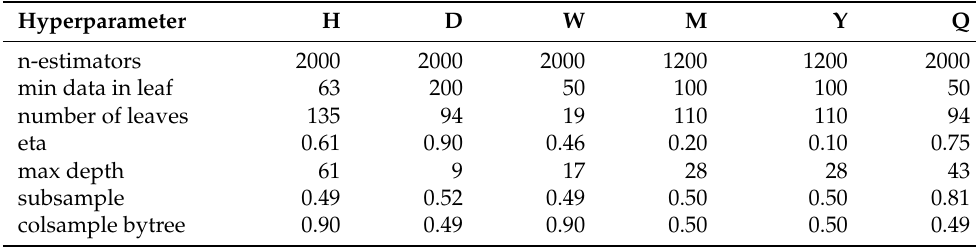
Table 2. The FFORMA